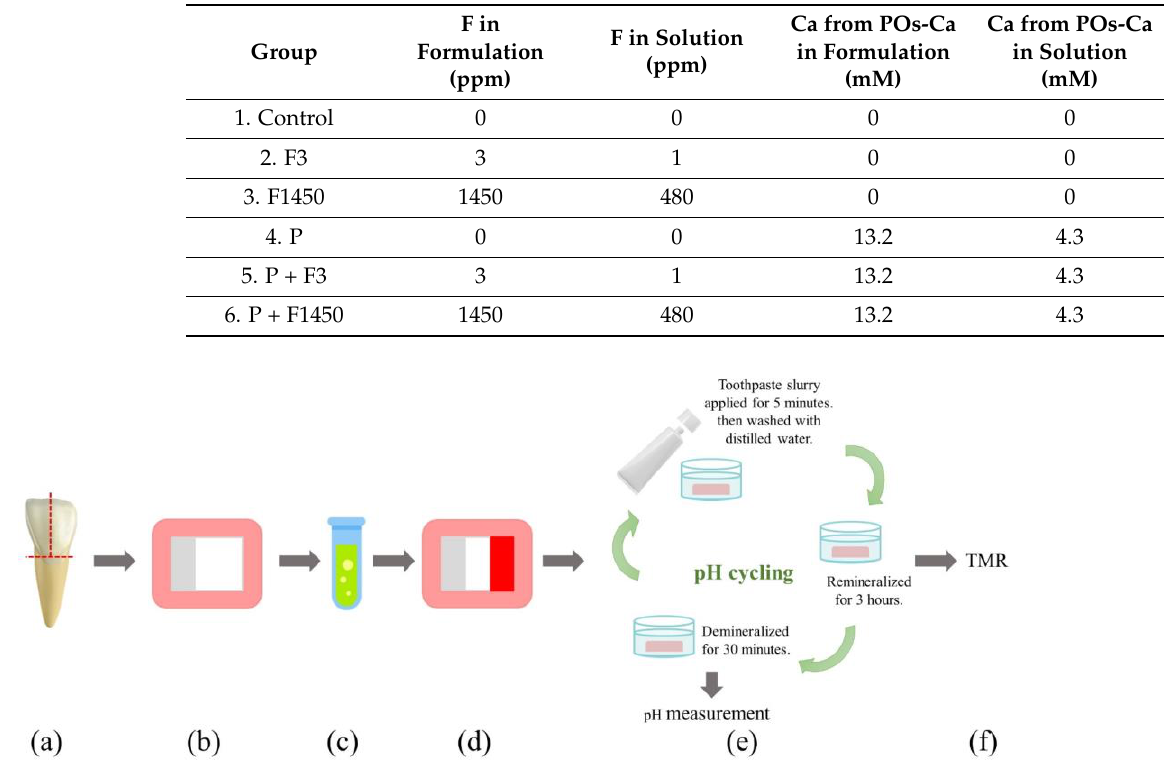
Figure 1. Illustration of specimen preparation. ( a ) Three-millimeter enamel samples obtained from bovine incisor teeth. ( b ) Embedding (epoxy resin) and making a window (5 × 10 mm) using nil varnish. Divided into two areas (made “sound”). ( c ) Soaking demineralization solution for 96 h at 37 ◦ C. ( d ) Application of nail varnish to 1/3 of the window (made “DEM”). ( e ) Performing pH cycling by 3 times/day for 8 days. Measuring the pH of demineralized solution. ( f ) TMR